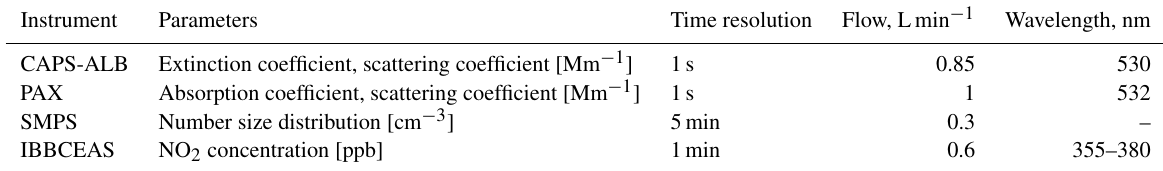
Table 1. Instrument